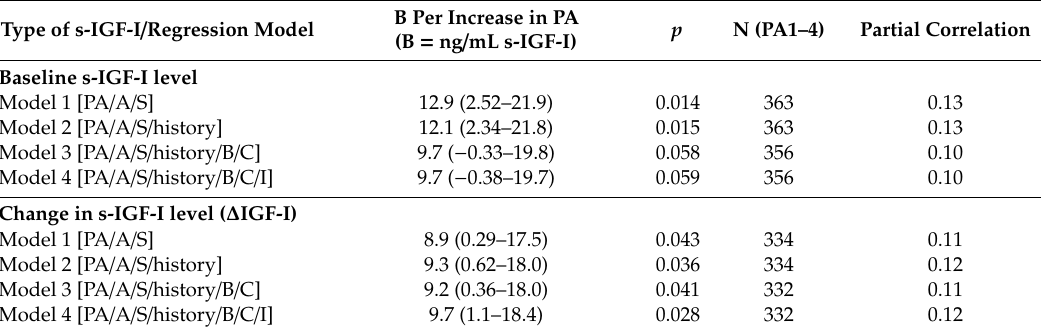
Table 2. Linear regression for serum insulin-like growth factor I (s-IGF-I) per increase in pre-stroke physical activity